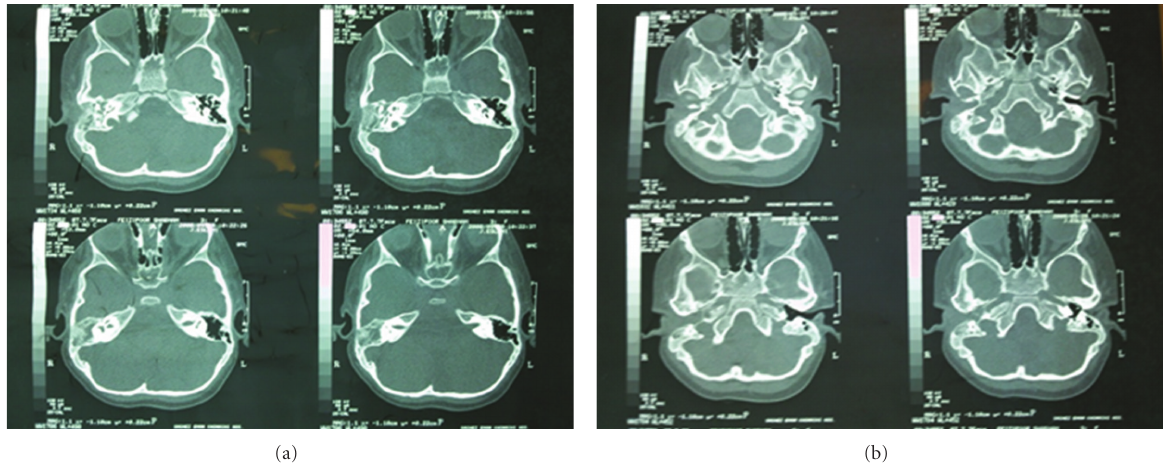
Figure 1: The mass involved external ear and projected from external auditory meatus. There was ragged erosion in mastoid air cells and external surface of mastoid bone.